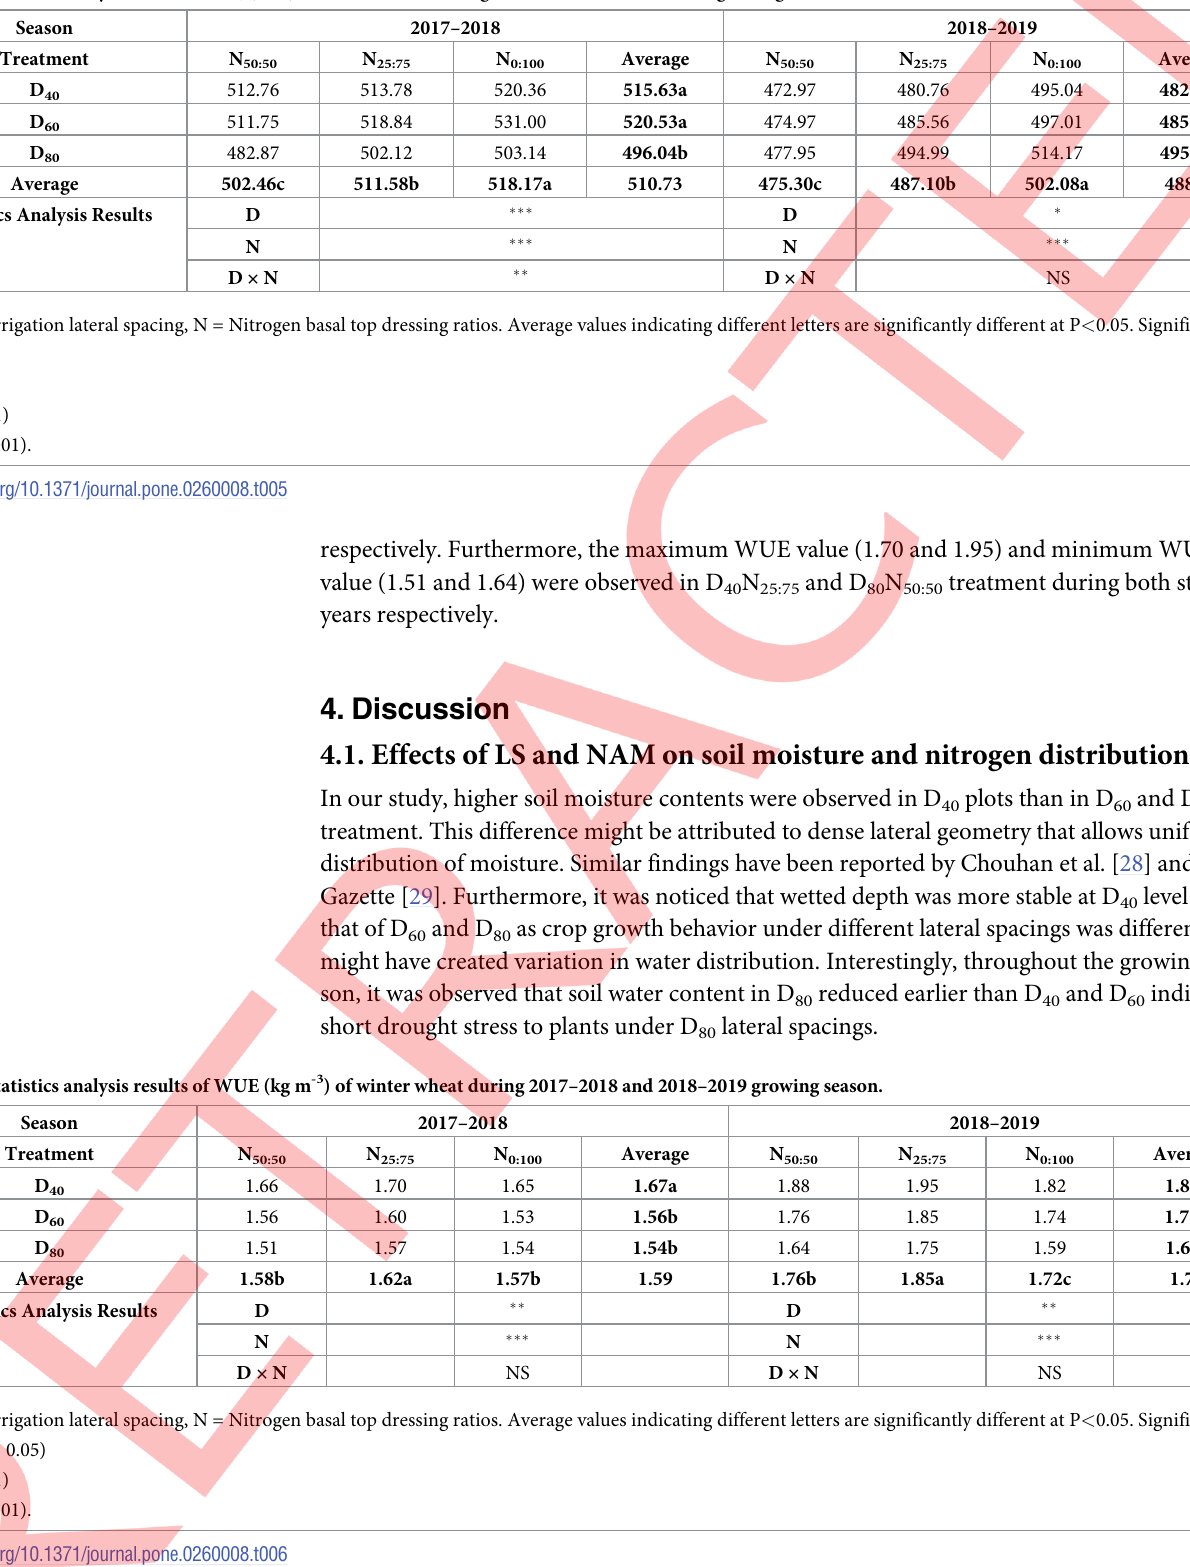
Table 5. Statistics analysis results of ET c (mm) of winter wheat during 2017–2018 and 2018–2019 growing season. Season